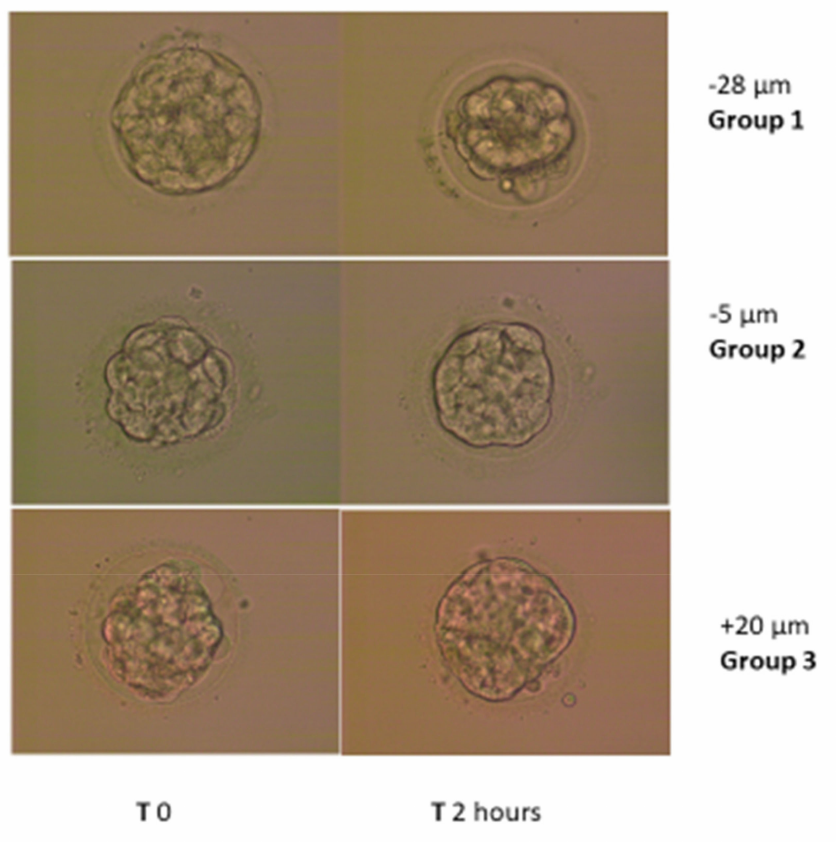
Figure 2. Examples of embryonic measurements and grouping